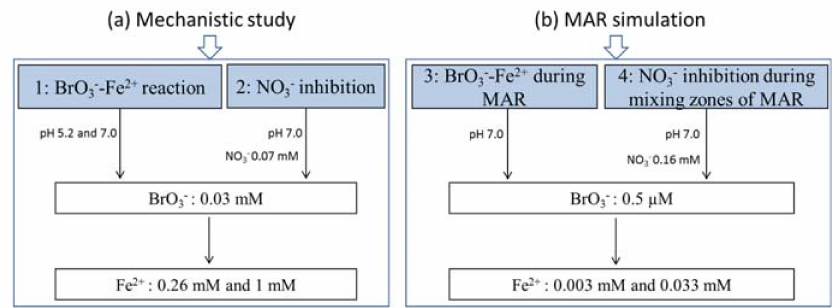
Figure 1. Experimental overview of anoxic batch reactors. T = 11.5 ± 0.5 ◦ C ( n = 2). MAR: managed aquifer